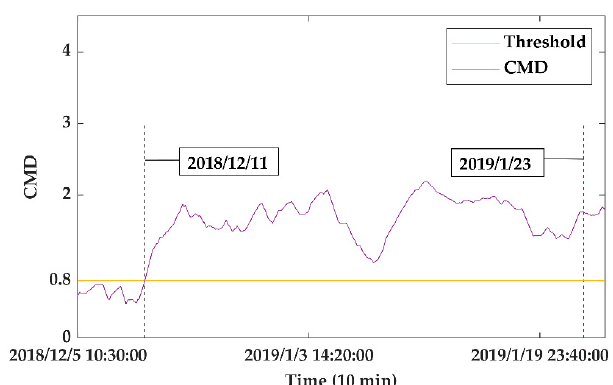
Figure 11. The changing curve of the CMD for hydropower units in case 3.